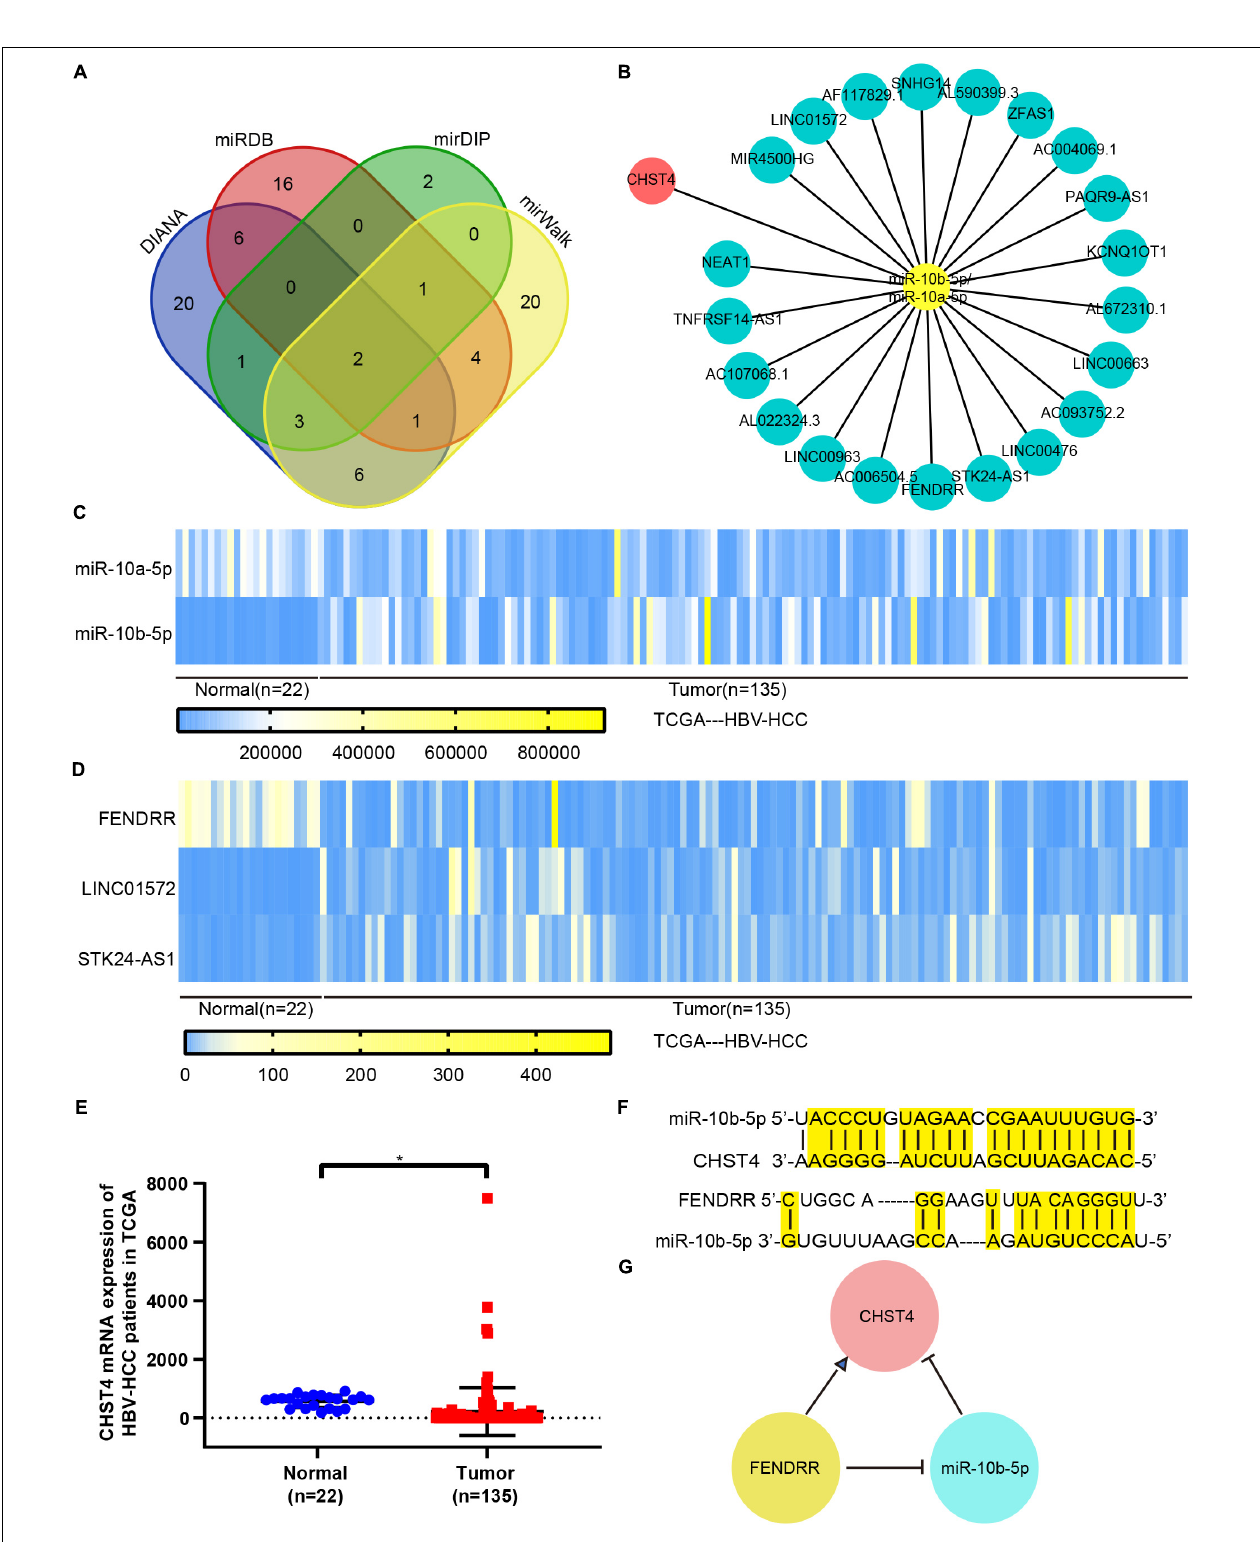
FIGURE 6 | The competing endogenous RNA (ceRNA) network for CHST4 in HBV-HCC. (A) Results of the predicted miRNAs using four different databases: miR-10b-5p and miR-10a-5p were finally screened. (B) Construction of the lncRNA–miRNA–CHST4 network. (C–E) The expression of mRNA, miRNA, and lncRNA in the network of HBV-HCC patients from The Cancer Genome Atlas. Bar represents the mean ± SD; * P < 0.05 (Student’s t -test).588896110588896110 (F) Complementary sequences between CHST4 and miR-10b-5p, and miR-10b-5p with FENDRR. (G) A ceRNA network constructed using FENDRR, miR-10b-5p, and CHST4 in